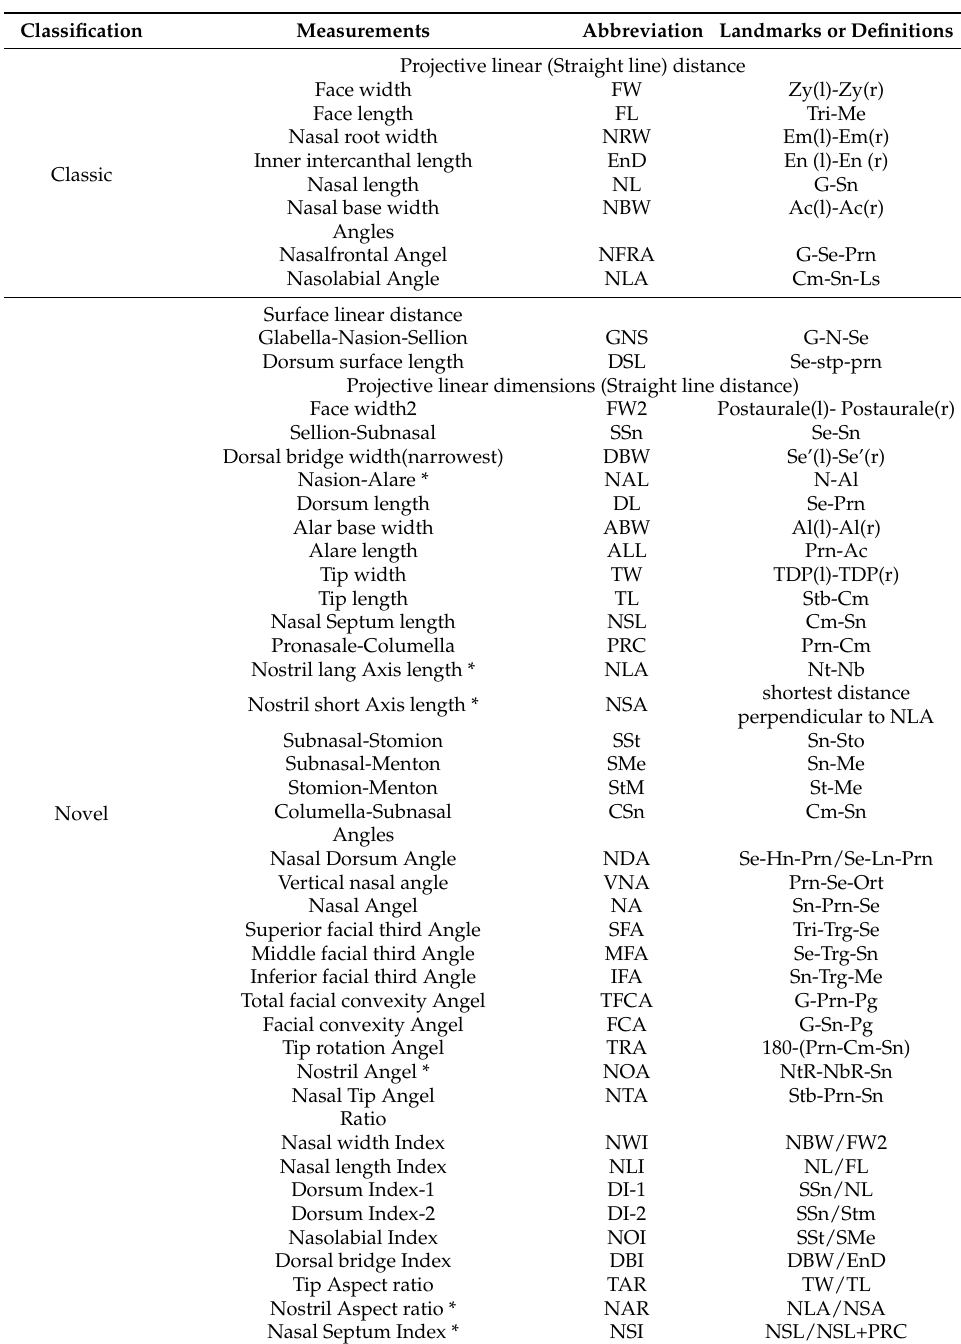
Table 3. List of 57 nasal anthropometric